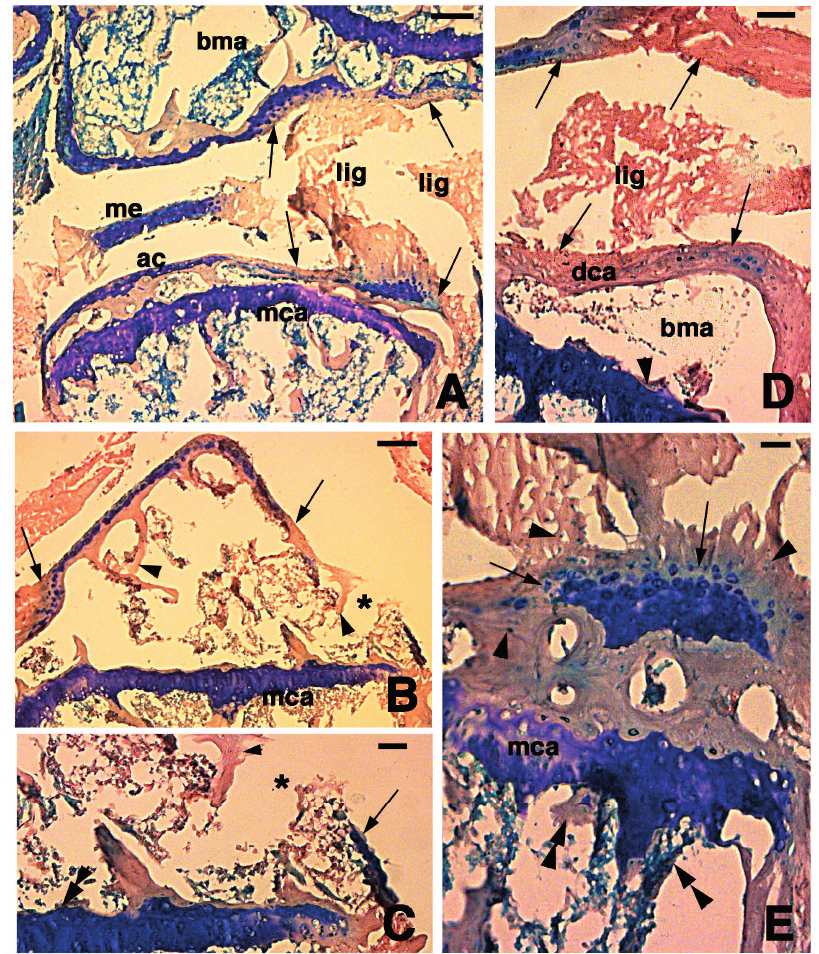
Figure 2. Histological aspects of the knee four days after the lesion. ( A ) The damaged ligaments, the meniscus, and the articular cartilages of the femur and tibia (arrows) are eosinophilic. Large part of the superficial articular cartilage has lost its basophilia to the methylene blue. The metaphyseal plates appear unchanged with respect to uninjured bones. Bar, 100 µm; ( B ) In this section, most of the basophilic articular cartilage has disappeared and is replaced by eosinophilic dense connective in continuation with bone trabeculae (arrowheads). The asterisk shows a hole in the degenerated cartilage corresponding to the point of lesion. Bar, 100 µm; ( C ) Detail on the hole (asterisk) bordered by completely eosinophilic degenerated cartilage (arrowhead) and a piece of cartilage showing some basophilia (arrow). The double arrowhead indicates the unchanged metaphyseal plate. Bar, 50 µm; ( D ) Detail showing the eosinophilic type of dense fibrous tissue (arrows) remained after cartilage degeneration on the femur (top arrows) and tibia (bottom arrows). Small regions containing basophilic chondrocytes remain. The arrowhead points to the basophilic metaphyseal plate. Bar, 50 µm; ( E ) Detail on the degenerated articular cartilage of a tibia showing an “island” of cartilaginous tissue (arrows) surrounded by small, possibly pyknotic cartilaginous cells (arrowheads). Double arrowheads indicate diaphyseal bone trabeculae. Bar, 25 µm. Legends : ac, articular cartilage; bma, bone marrow; lig, ligament; mca, metaphyseal (growth)